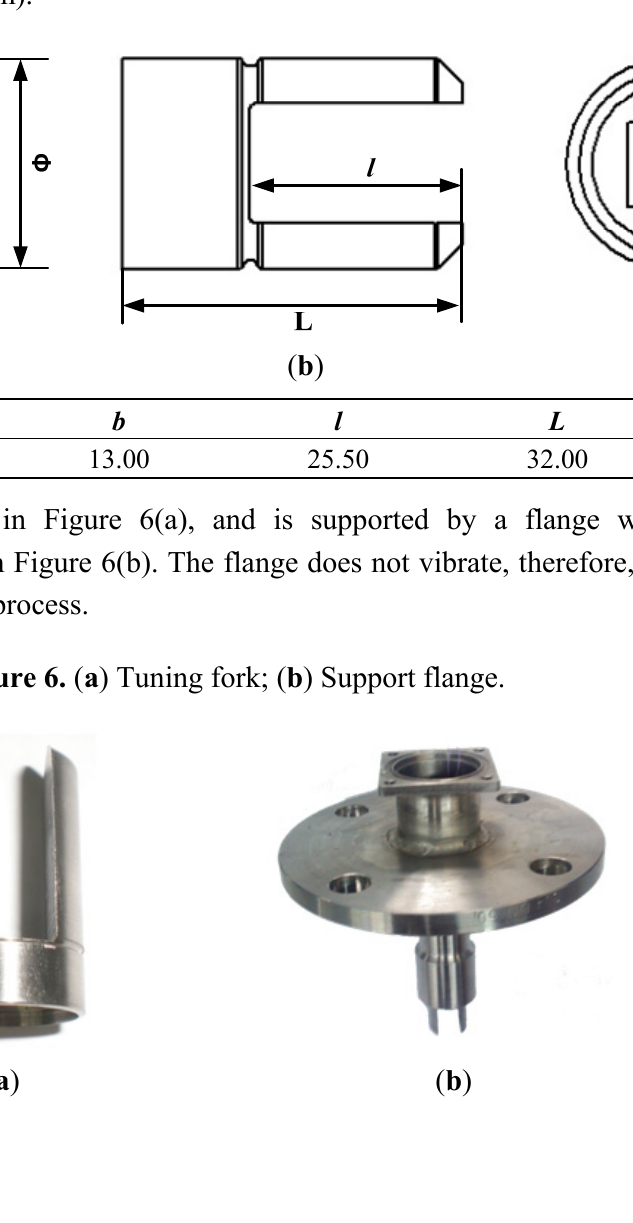
Figure 5. ( a ) Front view of the tuning fork; ( b ) Left view of the tuning fork; ( c ) Back view of the tuning fork (unit: mm).